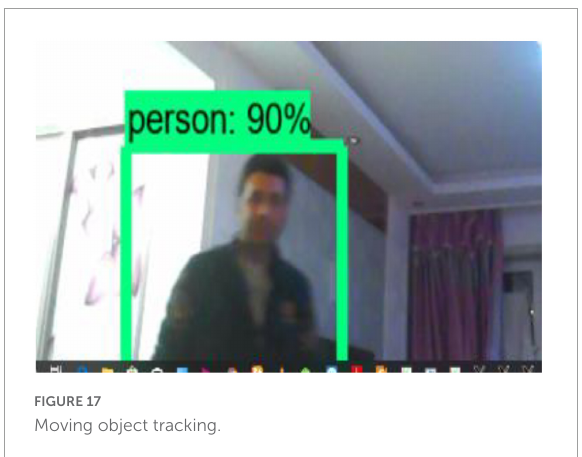
FIGURE17 Moving object